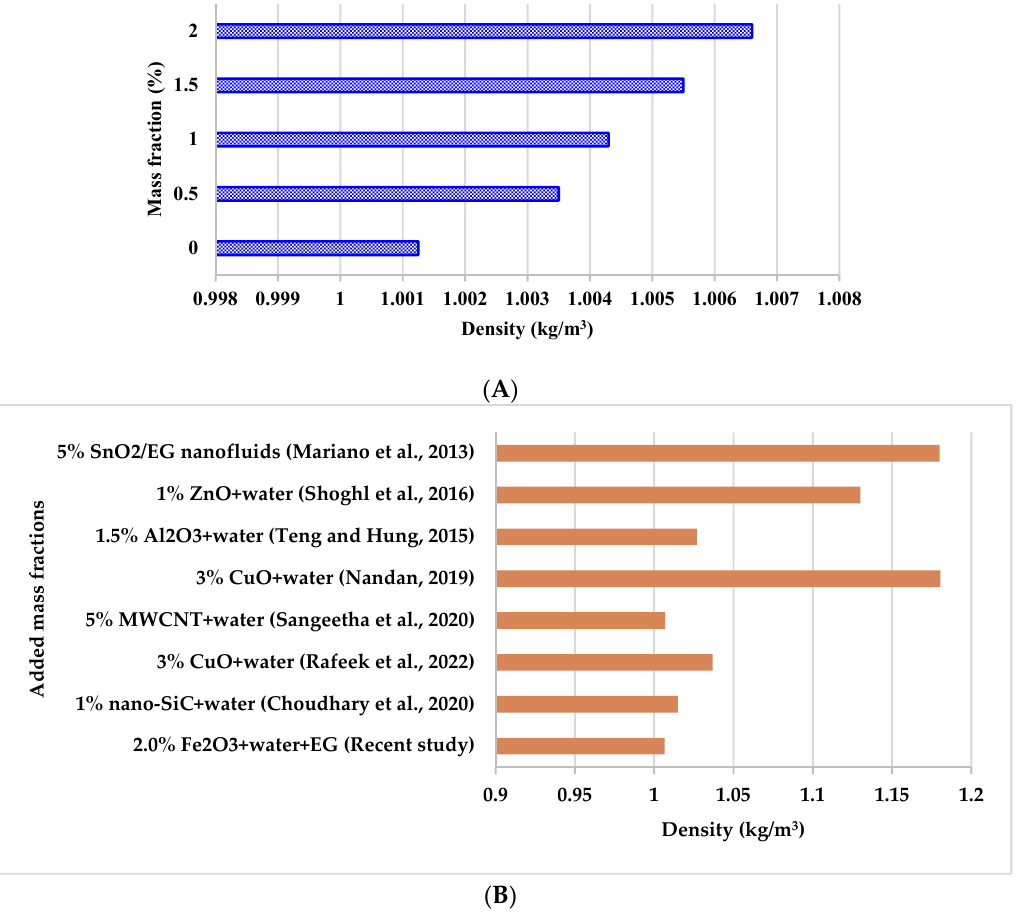
Figure 4. The effect of mass fraction added on resulted nanofluid density ( A ), and a comparison between recent study density and others from literature ( B ).